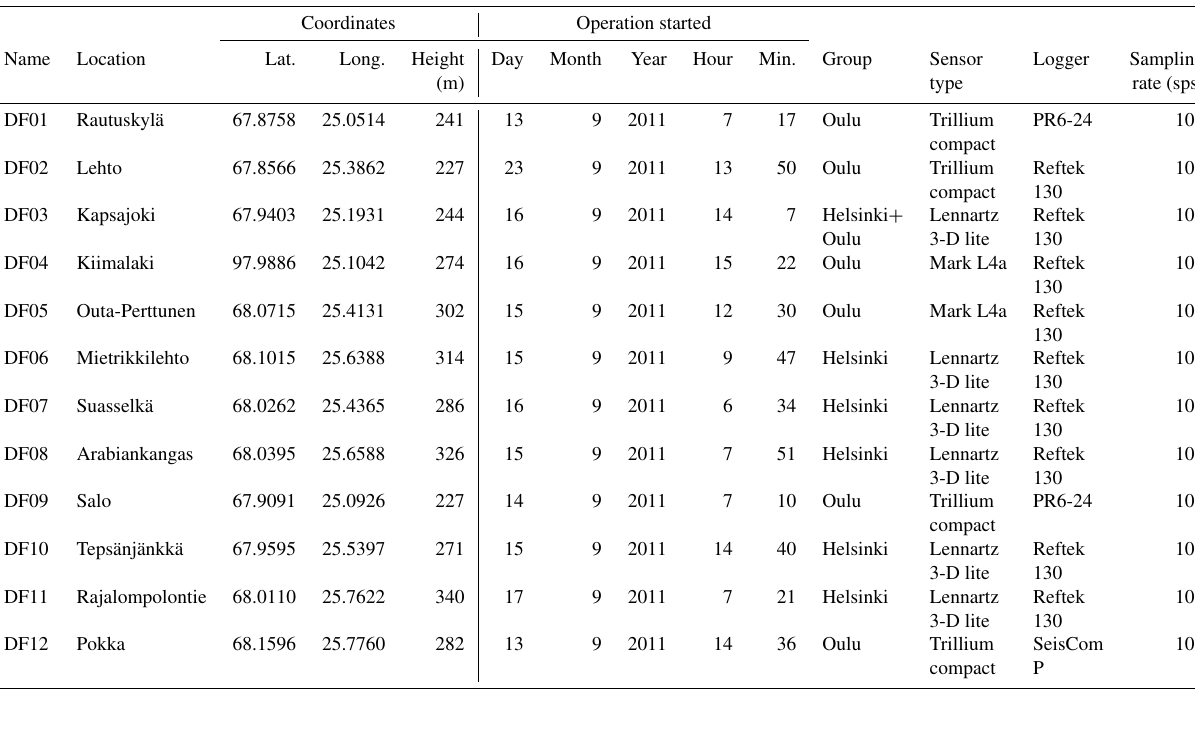
Table 1. Information about seismic stations of the DAFNE/FINLAND temporary array. Coordinates